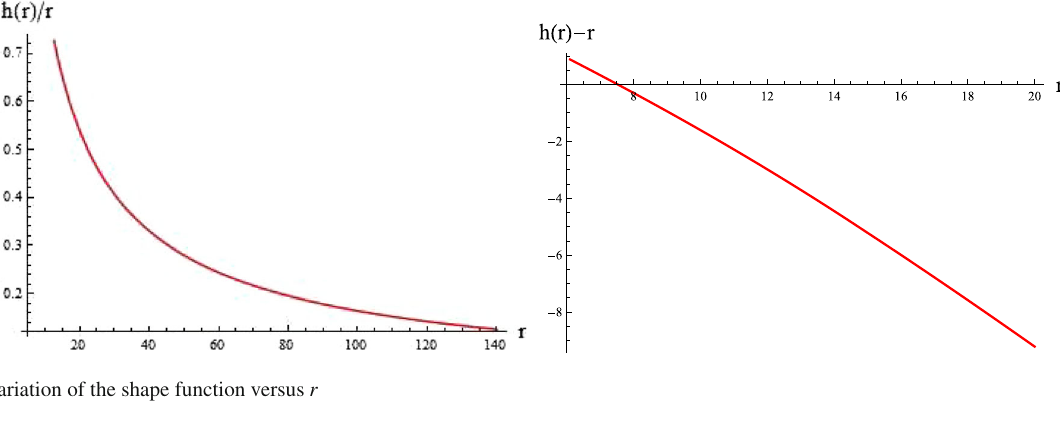
Fig. 6 Variation of the shape function versus r